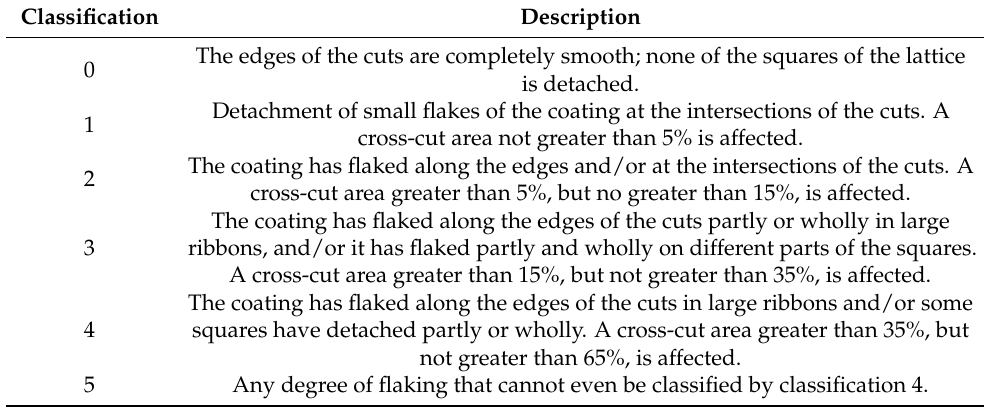
Table 1. Classification of test results for coating adhesion.